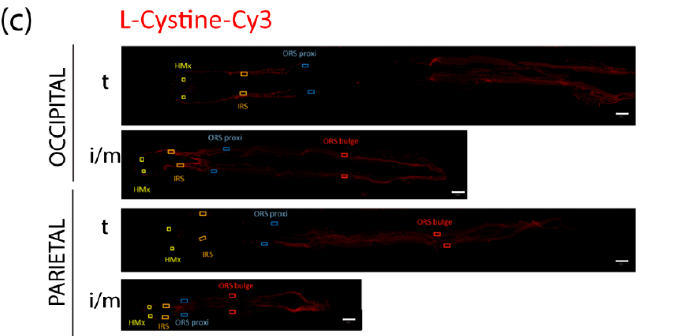
Figure 6. Intermediate FPHL HFs are able to absorb fluorescent labeled metabolites ex vivo. Represen- tative images of terminal hair follicles (t) from FPHL occipital and parietal scalp skin and of intermediate/ miniaturized hair follicles (i/m) from FPHL parietal scalp skin. Hair follicles were imaged after three hours of starvation in PBS and one hour ex vivo culture in WCM medium supplemented with three fluorescent-labeled metabolites: pantothenic acid-FAM ( a ), glutamic acid-Cy5 ( b ), and L-cystine-Cy3 ( c ). Scale bars: 100 µ M. HMx: hair matrix, IRS: inner root sheath; ORS: outer root